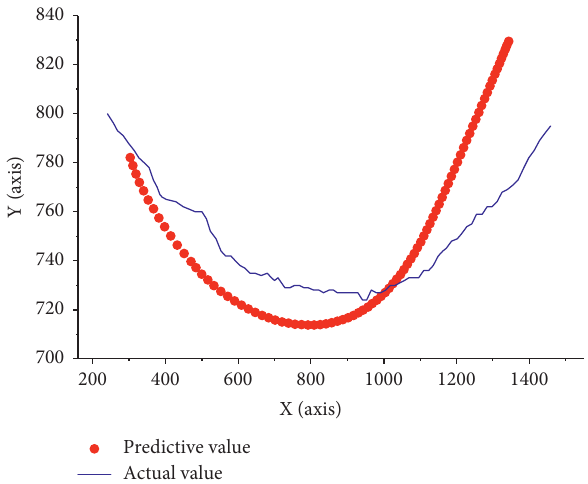
Figure 20: Prediction result of the right-turn